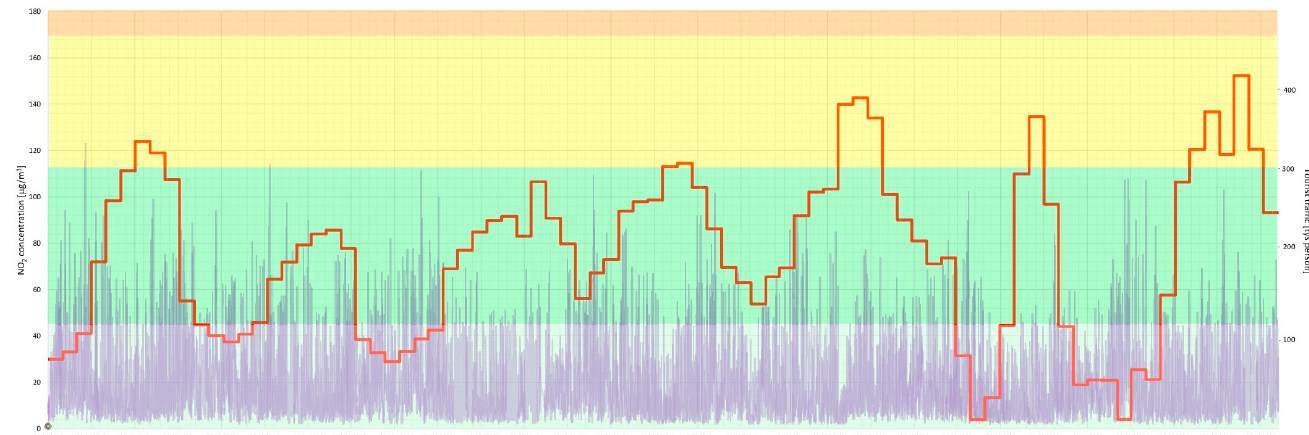
Figure 10. NO 2 concentration in relation to tourist traffic (the Gda ń sk agglomeration, years 2015– 2021). Source: own study.